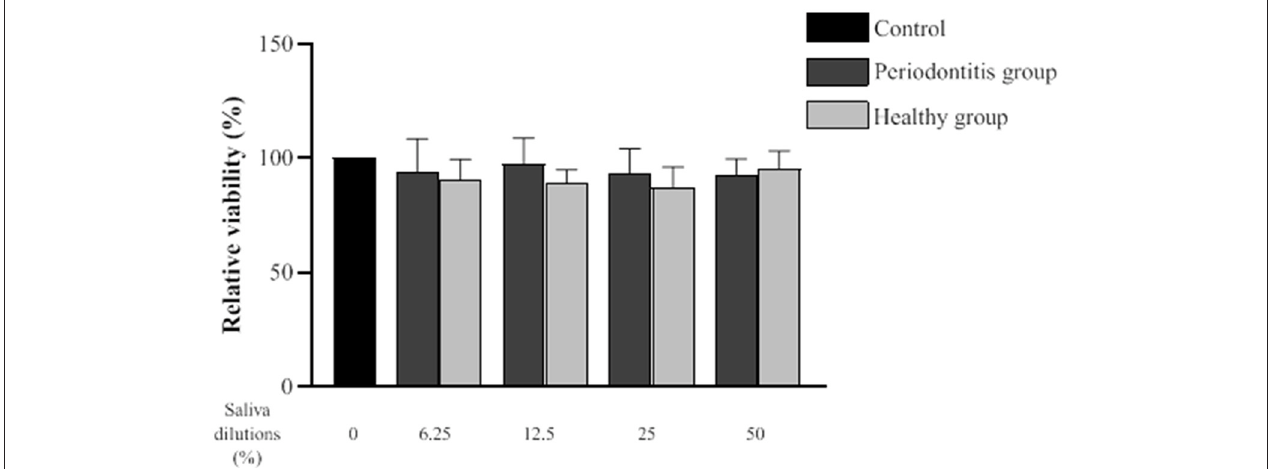
FIGURE 4 | Effect of various dilutions of filter-sterilized saliva from the periodontitis and healthy groups on epithelial cell viability. The MTT colorimetric assay was performed after a 24-h exposure to saliva. Data are expressed by subject group as the mean ± SD of the relative cell viability values from triplicate assays. No significant difference ( p < 0.05) was observed between the periodontitis, healthy, and control groups at any saliva